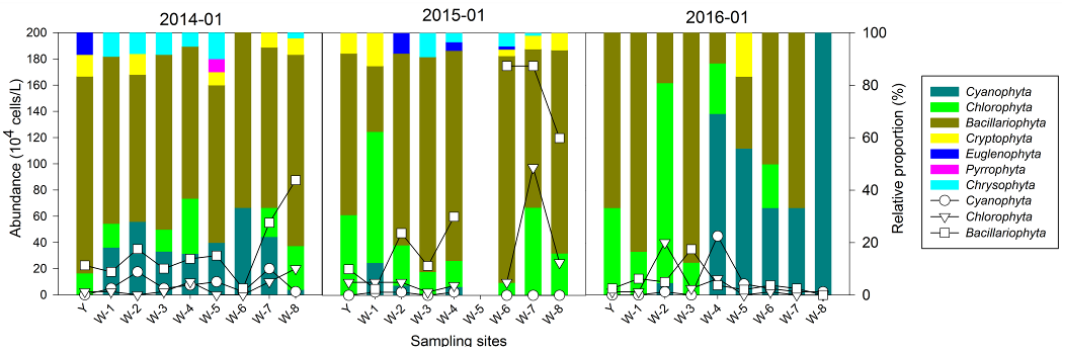
Figure 5. The abundances and relative proportions of phytoplankton phyla in January of different years in the Wangyu River channel.